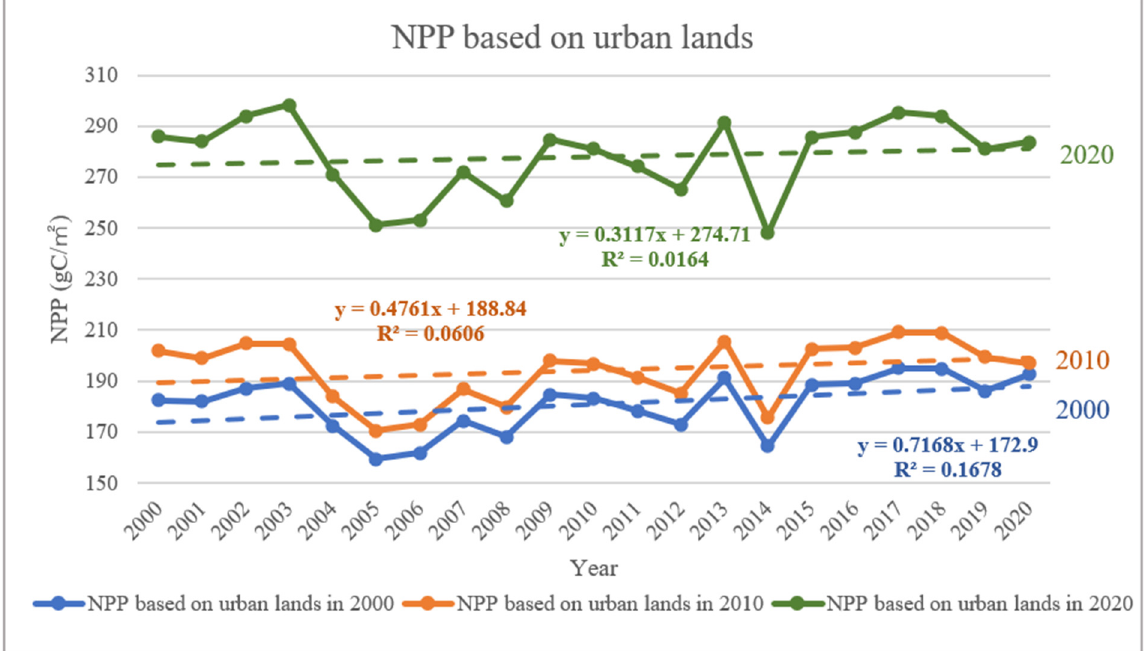
Figure 4. Net primary productivity (NPP) trends based on urban land.